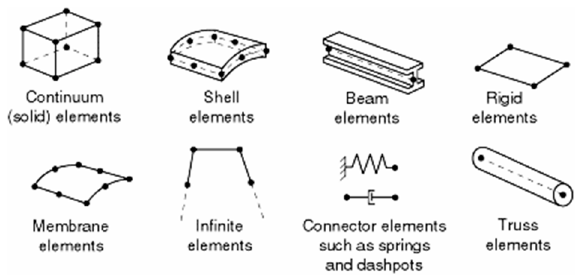
Figure 4. Commonly used element families in ABAQUS [29].